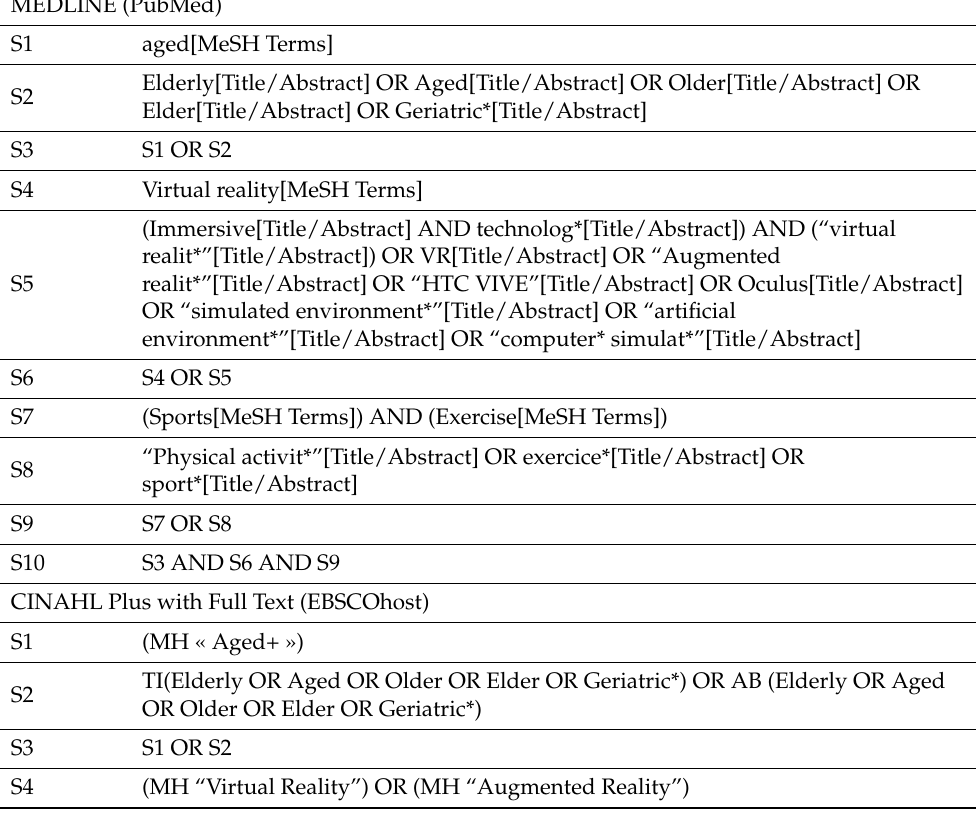
Table A1. Search strategy in each